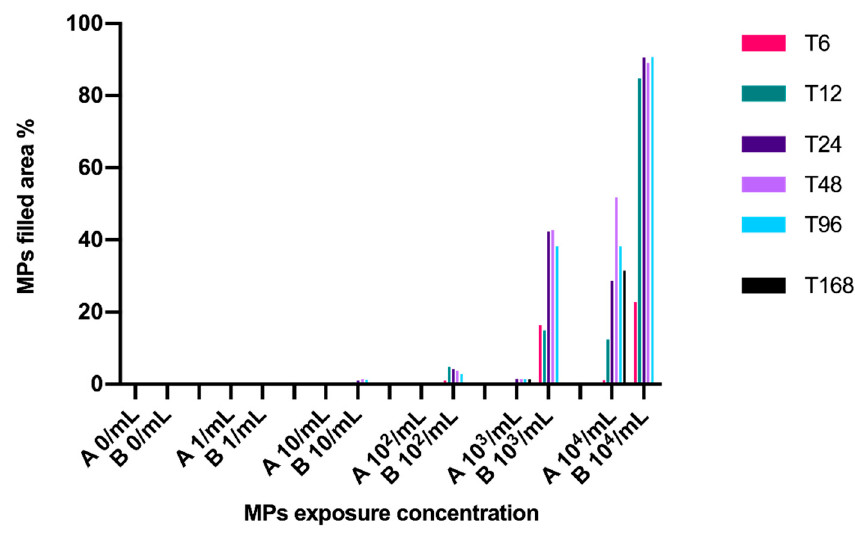
Figure 8. Artemia salina MPs filled area (%) at each concentration and experimental time. Additionally, the microalgae ingestion rate (%) showed a negative correlation with the MPs-filled area (r = − 0.9; p < 0.001) and with MPs ingestion (r = − 0.7; p < 0.001).